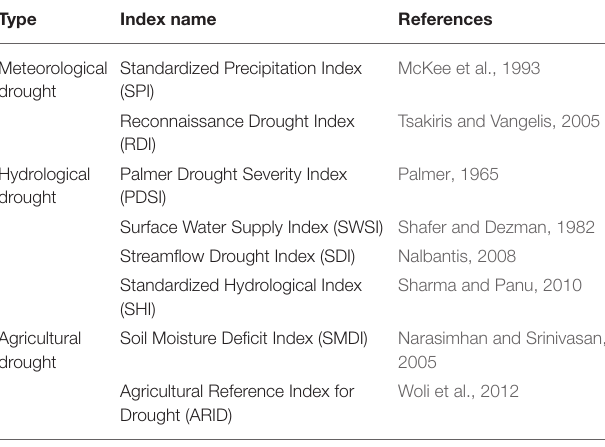
TABLE 1 | Commonly used drought indices of three types (Yeh, 2019).